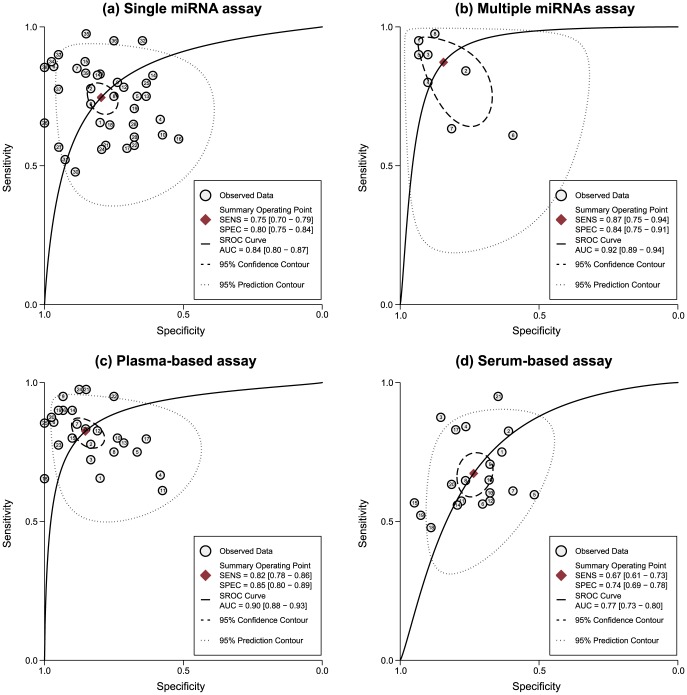
SROC curve with pooled estimates of sensitivity, specificity and AUC on the diagnostic value of circulating miRNAs in GC detection (a: single-miRNA assay; b: multiple-miRNAs assay; c: plasma-based assay; d: serum-based assay).